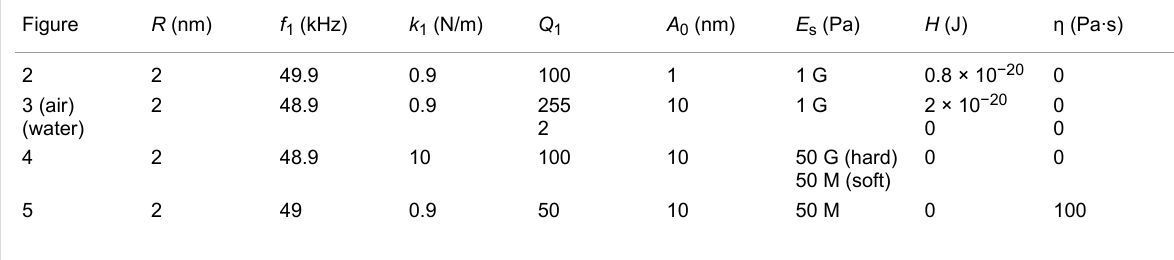
Table 3: Summary of the parameters used in the numerical simulations described in Figures 2–5. Figure